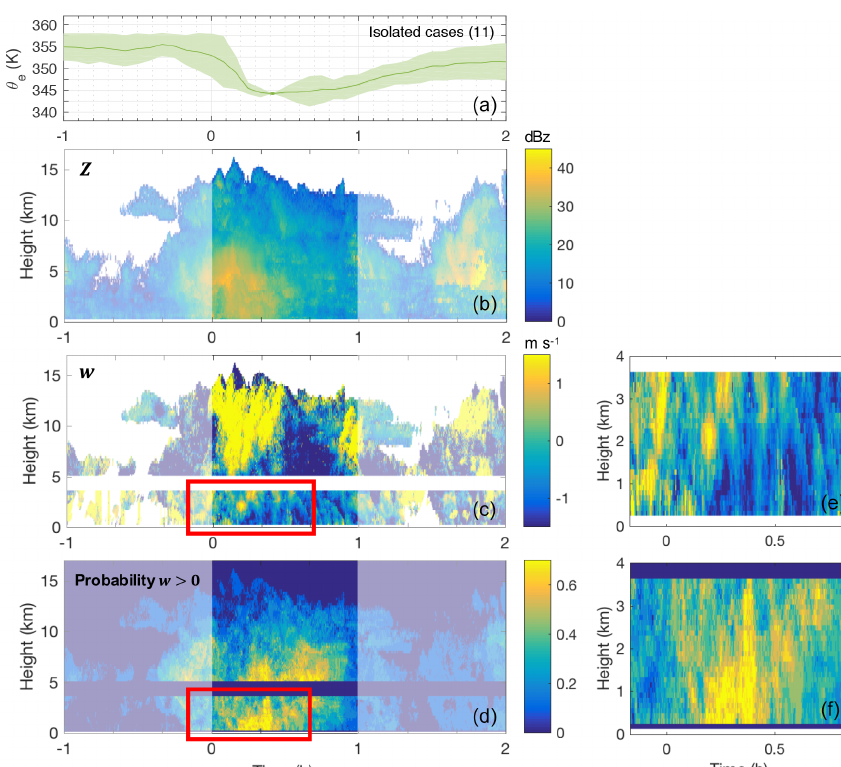
Figure 4. The composite θ e (K; a ), mean reflectivity (dBZ; b ), mean vertical velocity ( c ; ms − 1 ) , and probability of w <0ms − 1 (d) observed by the radar wind profiler at T3 leading and lagging the passage of isolated cells. Plots of w (e) and probability (f) zoomed in time and height (as outlined in red) are shown to the right of the corresponding plots for visual